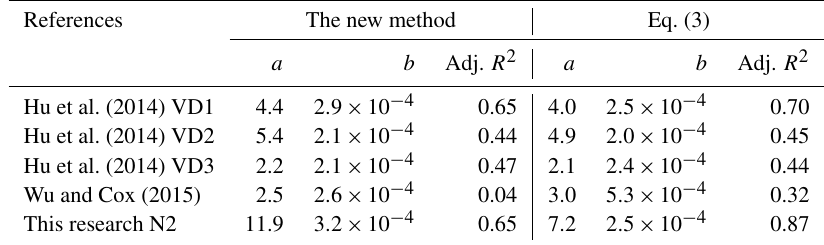
Table 3. Outcome of the factors in Eq. (15) between Re and C D by the new method and by Eq. (3).